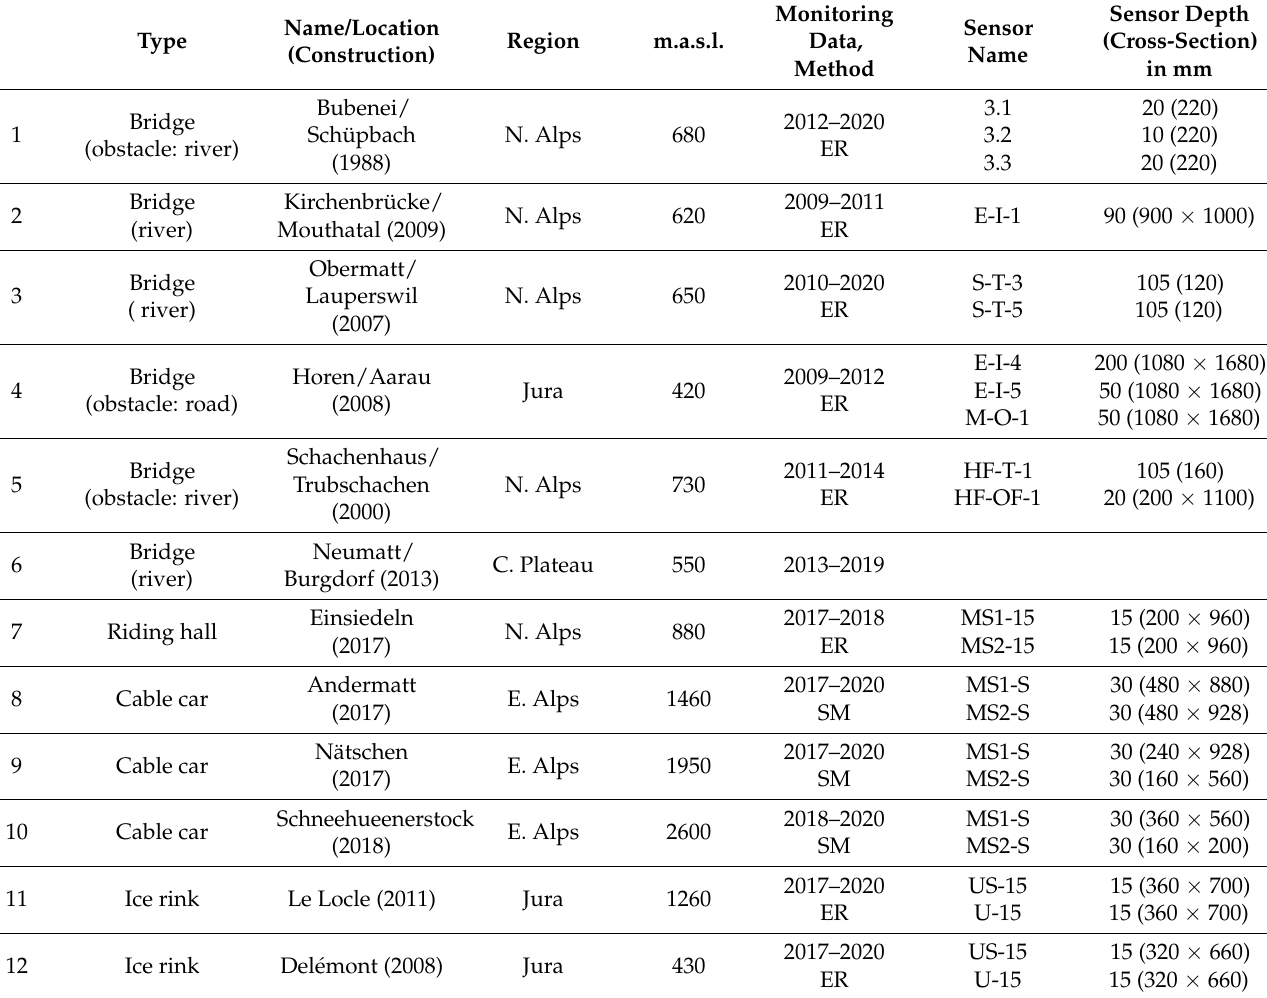
Table 2. List of structures with erection date, duration of monitoring, type of measurement (electrical resistance (ER) or sorption method (SM)), sensor depth, and cross-section dimensions (only one dimension is given if the measurement was taken in a stress-laminated timber